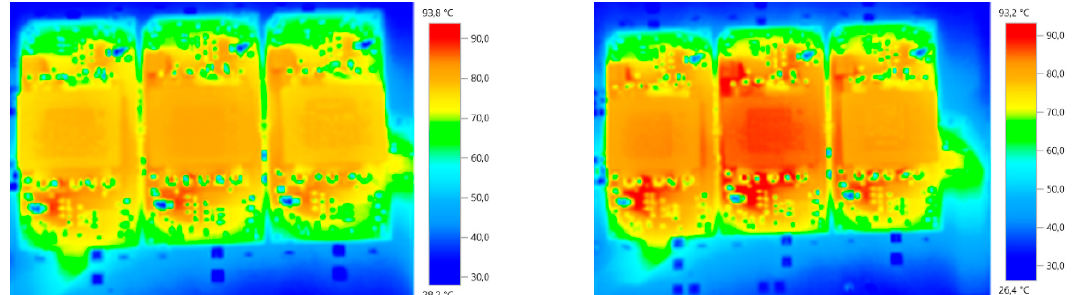
Figure 14. ISOP configuration of CSC A,1 CSC A,2 CSC A,3 (left) and CSC C,1 CSC C,2 CSC C,3 (right) in same electrical configuration for electrical Test 2.